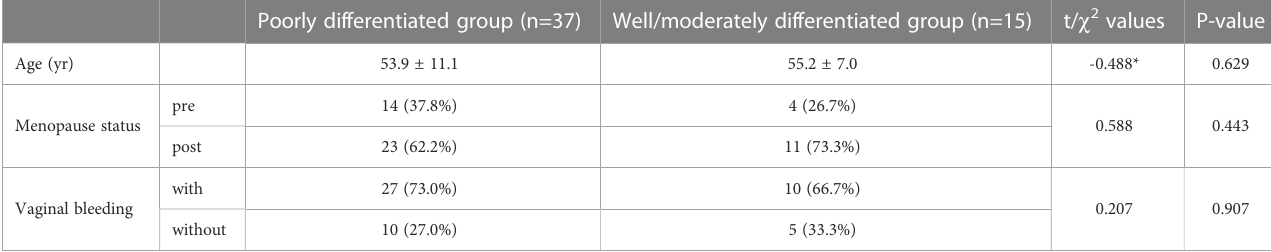
TABLE 1 Comparison of clinical data of patients in the poorly differentiated and well/moderately differentiated